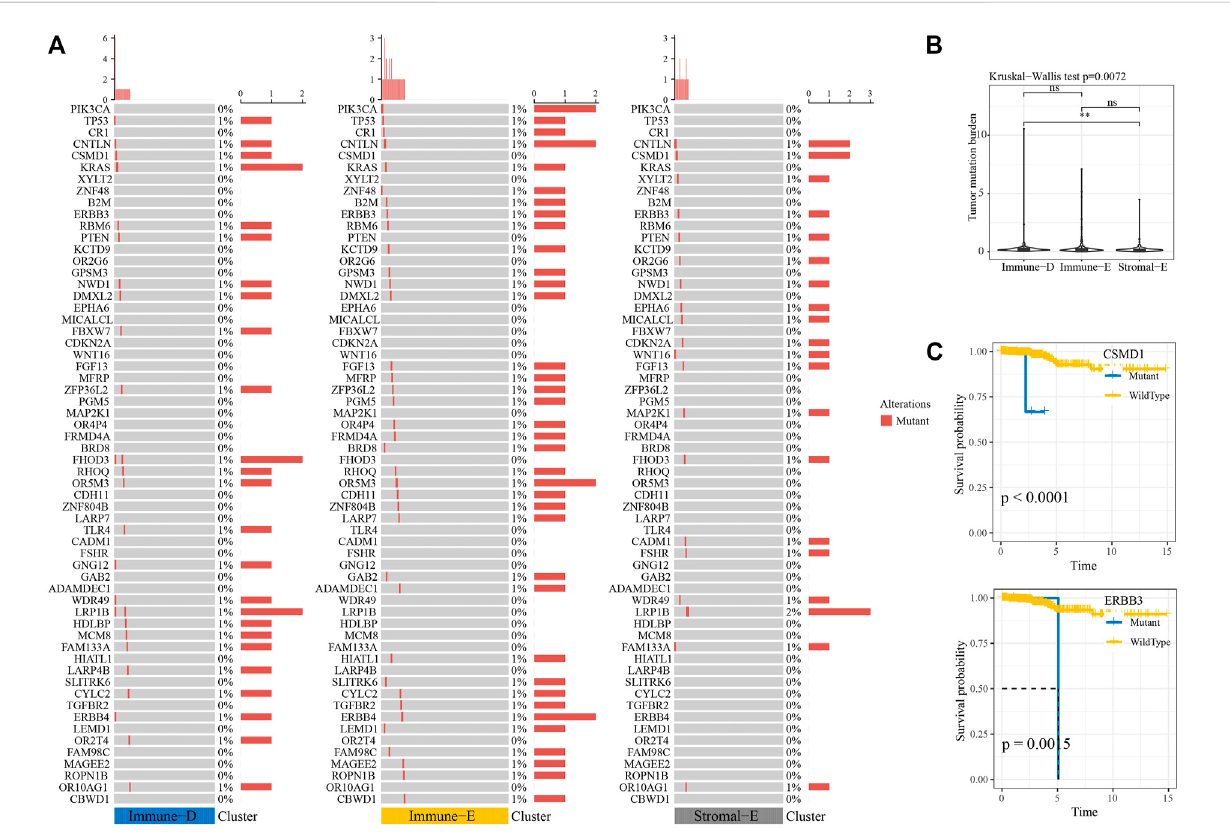
FIGURE 4 Mutation analysis oftumor-drivinggenes. (A) Mutation analysisoftumor-drivinggenesamongthethreemolecularsubtypes. (B) DifferencesinTBM among the three molecular subtypes. (C) KM survival curves of CSMD1 and ERBB3 mutants and wildtype. ** p < 0.01; ns: no signi fi